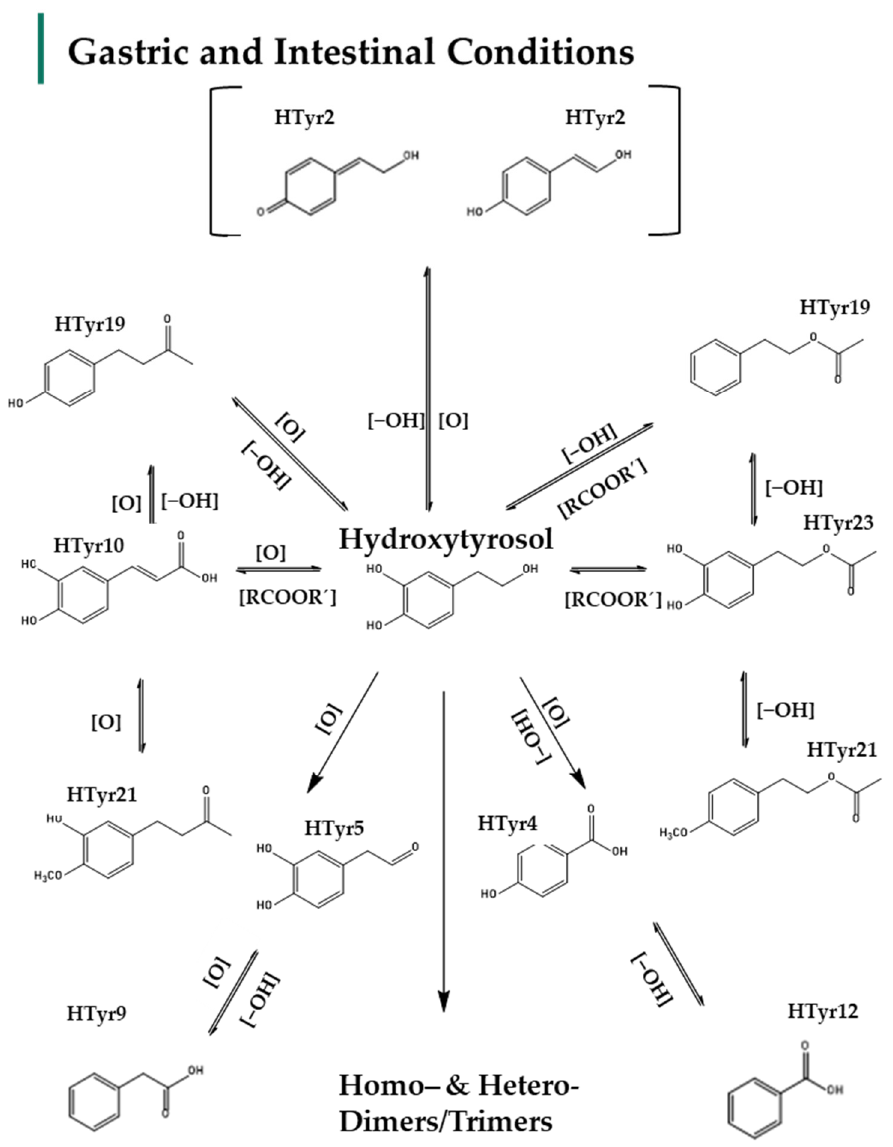
Figure 2. Suggested metabolism pathway of HTyr under gastric (pepsin solution, pH: 2, T = 37 °C) and intestinal conditions (pancreatin, bile solution, pH: 7.5, semi–anaerobic conditions, T = 37 °C). HTyr2 , HTyr19 , HTyr21 , HTyr23 are not detected in small intestine. In more detail, the HTyr metabolites detected in all compartments are mostly oxidized forms (e.g., HTyr3 , HTyr5 , HTyr18 ), esters (e.g., HTyr19 , HTyr23 , HTyr24 ), or methylated ( HTyr21 , HTyr23 ), dehydrogenated (e.g., HTyr2 ), dehydroxylated (e.g., HTyr19 ) deriva- tives, but also oxidized derivatives with shorter side chain (e.g., HTyr4 , HTyr12 ) as well as combinations thereof. Due to the structural similarity to Tyr, several metabolites could be structurally considered as Tyr derivatives as well. Amongst these metabolites